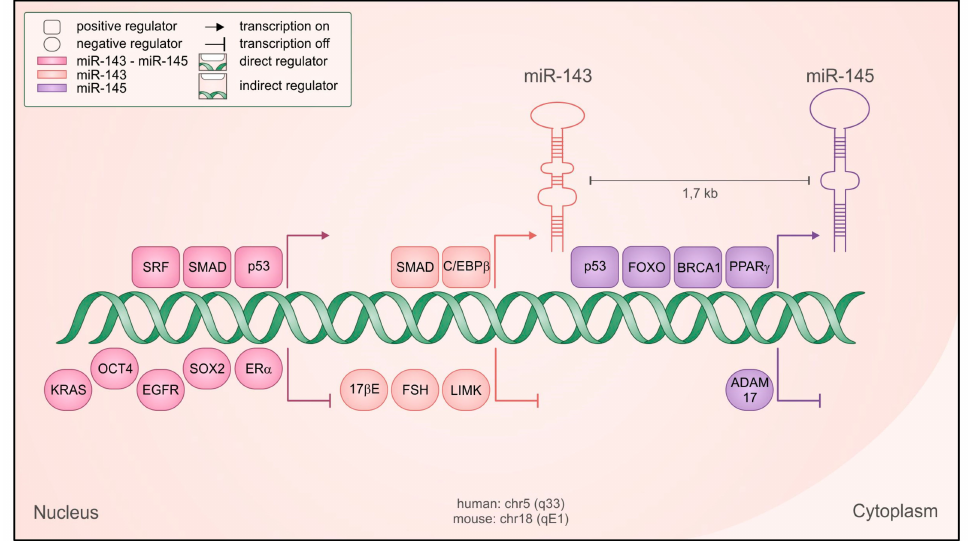
Figure 1. Regulation of miR-143 and -145 transcription. Schematic representation of the genetic locus containing the microRNAs, with both positive (squared) and negative (rounded) regulators shown to be relevant for their transcription, in both normal and cancer cells. Regulators with direct transcriptional activity are depicted closer to the DNA, and the color code indicates if they regulate both microRNAs as a cluster (fuchsia) miR-143 only (pink), miR-145 only